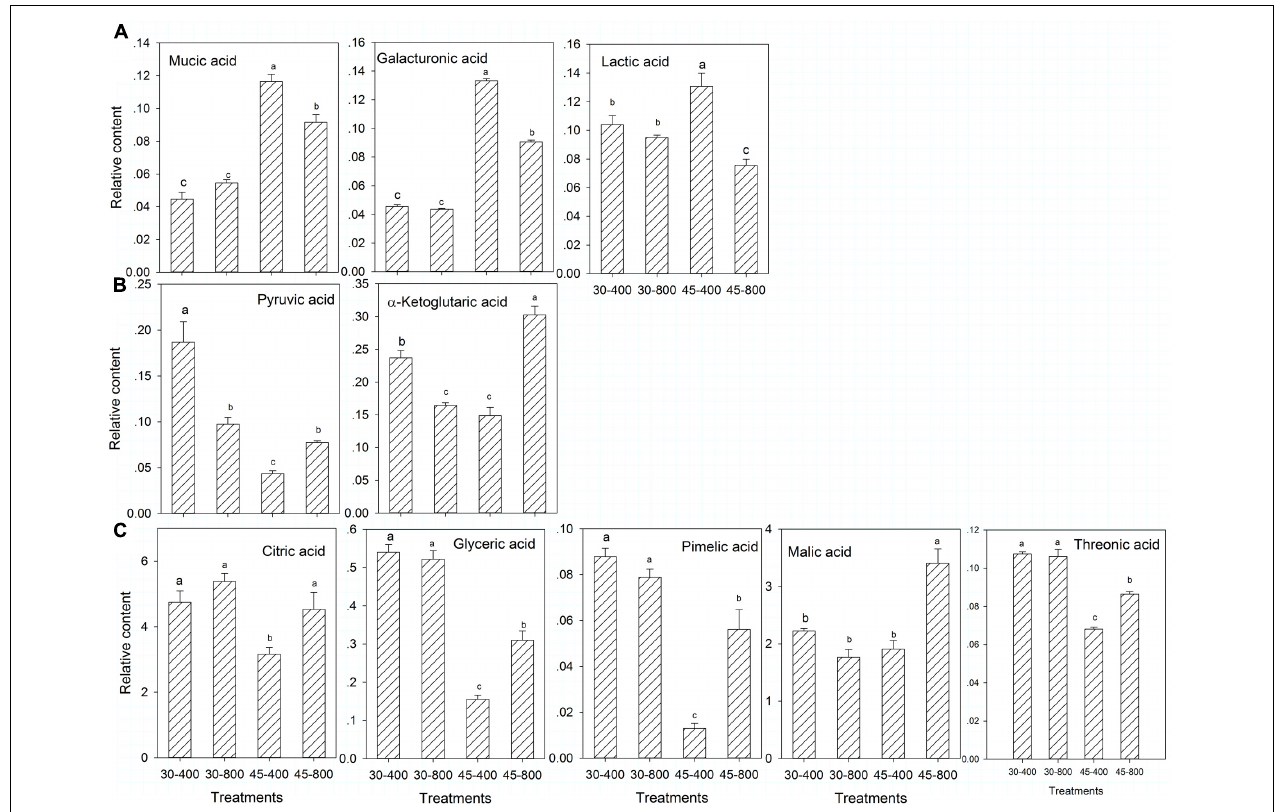
FIGURE 4 | Effects of elevated CO 2 concentration on organic acids in response to heat stress in bermudagrass. The treatments symbols are 30 and 45 for normal temperature control and heat stress and 400 and 800 for ambient CO 2 and elevated CO 2 concentrations, respectively. (A) No changes under 30–800 and down-regulation under 45–800; (B) No changes under 30–800 and up-regulation under 45–800; (C) Down-regulation under 30–800 and up-regulation under 45–800. Columns marked with different letters presented the significant differences based on LSD values ( P ≤ 0.05) among